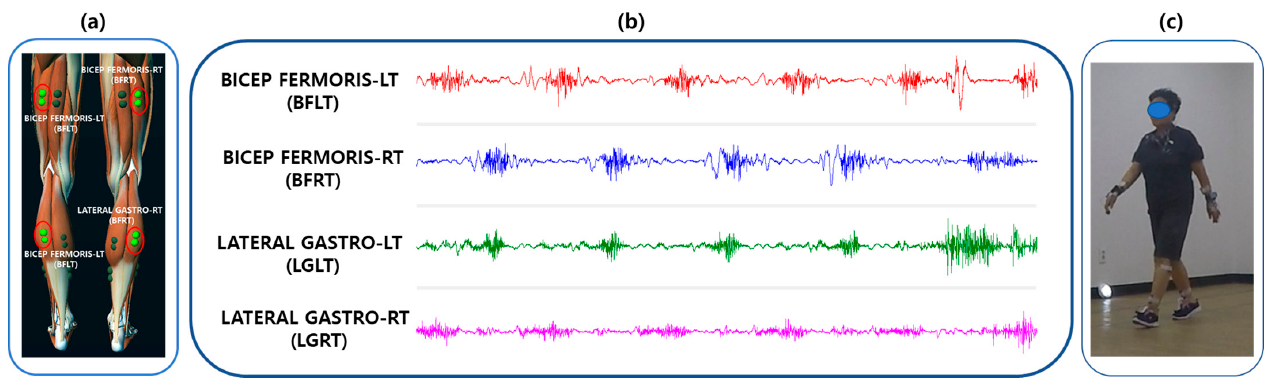
Figure 2. Electrode positions and layout of EMG data acquisition. ( a ) Four-channel EMG electrode positions based on bicep femoris muscles and lateral gastrocnemius muscles of both lower limbs. ( b ) EMG pre-processed signal recorded from four electrode positions. ( c ) An experimental scenario of a post-stroke patient.